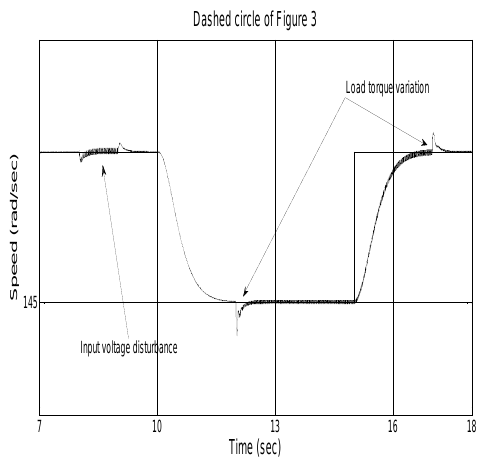
Figure 3.The tracking performance of the proposed control scheme.